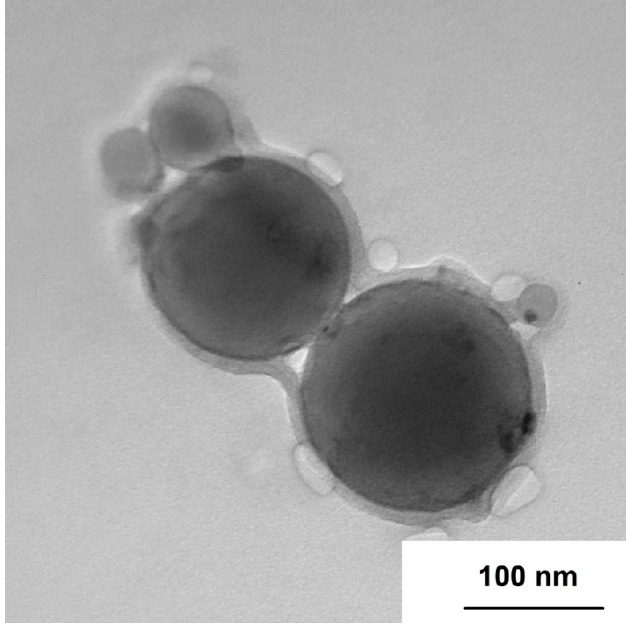
Figure 3. Aluminum nanoparticles coated with HTPB.